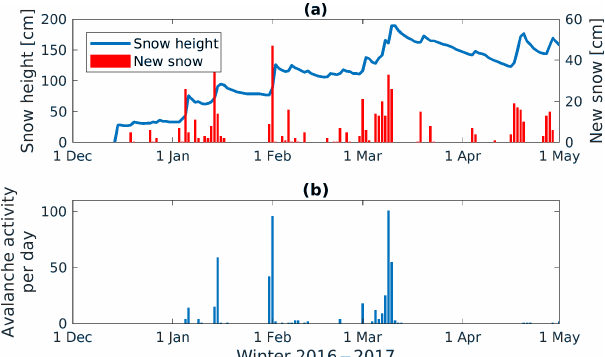
Figure 7. (a) Snow height measured (blue line) at the automatic weather station at Weissfluhjoch 12km to the northwest of the Dischma array at 2540ma.s.l. for the 2016–2017 winter season. Red bars are the height of new snow measured each day at 08:00LT. (b) Number of avalanches observed per day in the Davos region ( ∼ 175km 2